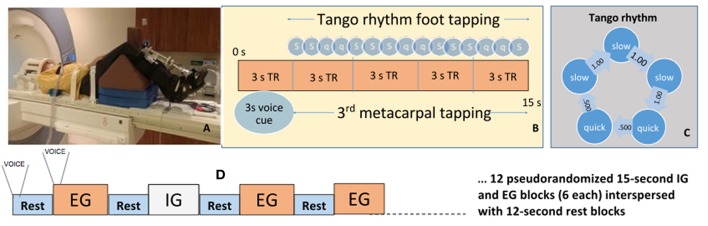
Activation paradigm and participant fMRI setup. (A) Participant prepped for scanner. (B) Ideal foot-tapping sequence within each active block. (C) The slow, slow, quick, quick, slow tango rhythm was used as the target rhythm for participants. (D) Activation paradigm for internally and externally guided blocks. Voice, voice cue.